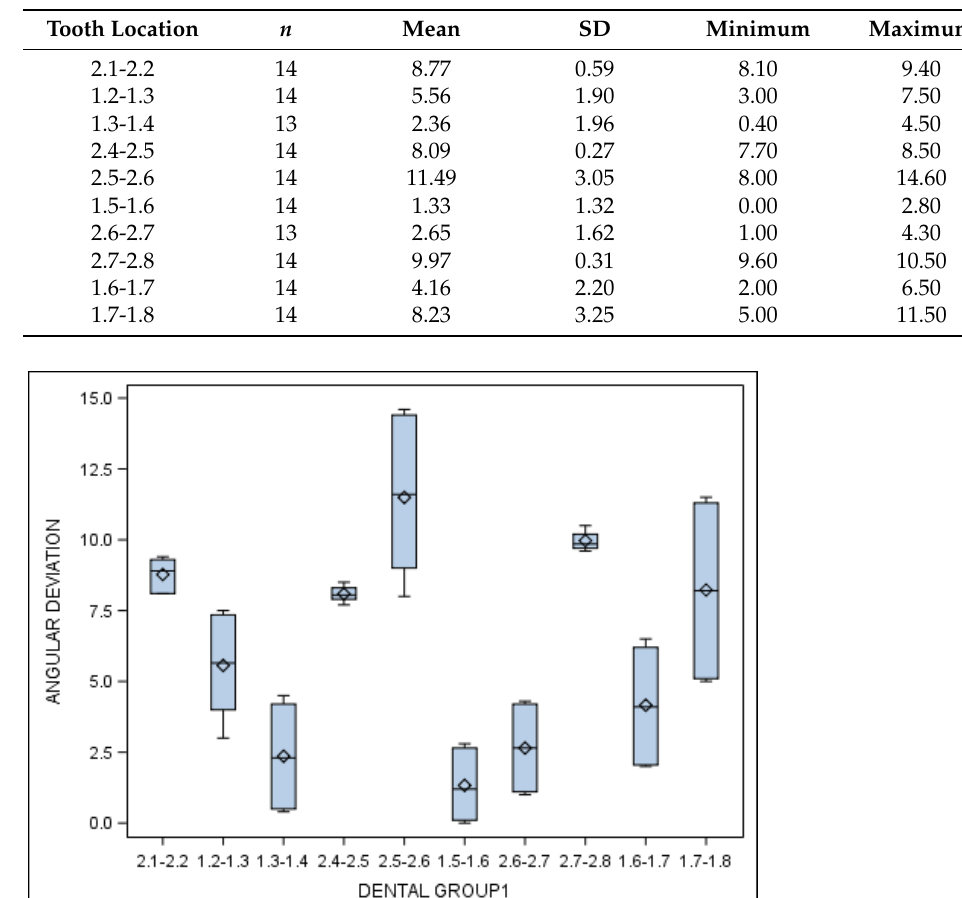
Table 7. Descriptive deviation values at angular level ( ◦ ) of the orthodontic micro-screws placed in the selected tooth positioning.